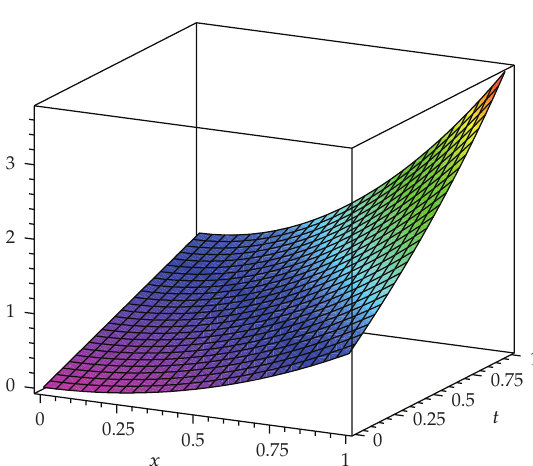
Figure 2: Approximate solution of the nonlinear di ff usion problem on the interval (cid:5) 0 , 1 (cid:6) .